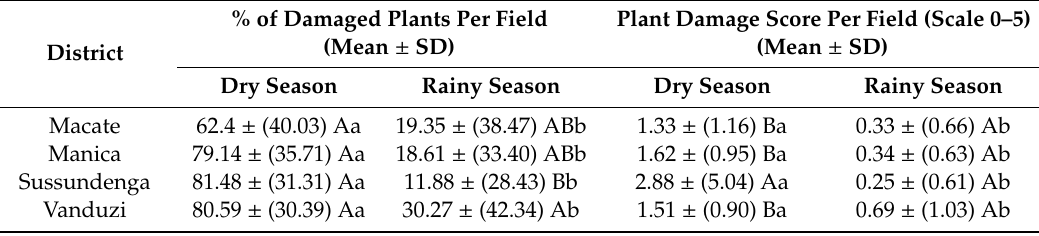
Table 2. Percentage of damaged plants per field and average plant damage score per field per district and season of sampling.